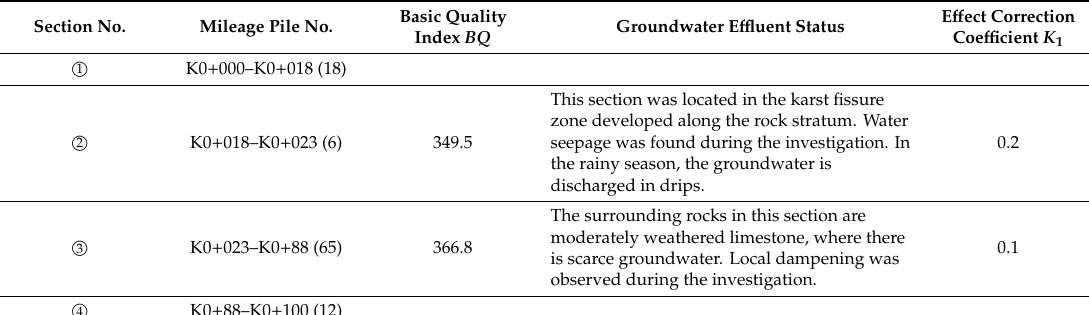
Table 2. Groundwater e ff ect correction factor K